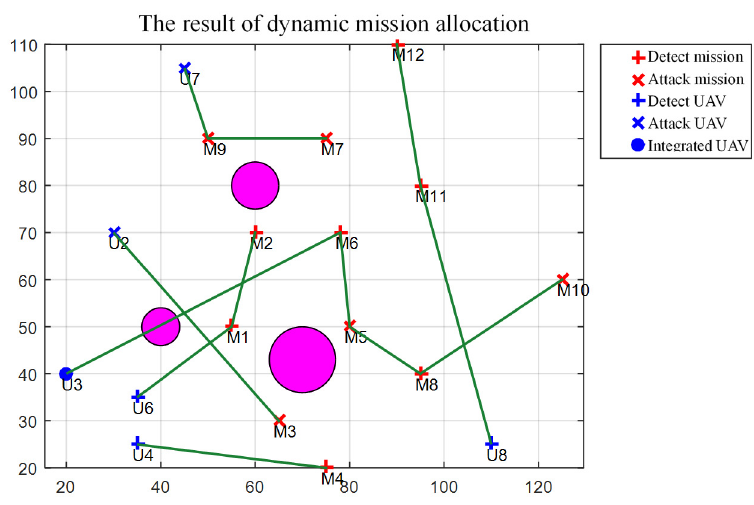
Figure 7. Task allocation results after UAV failure.